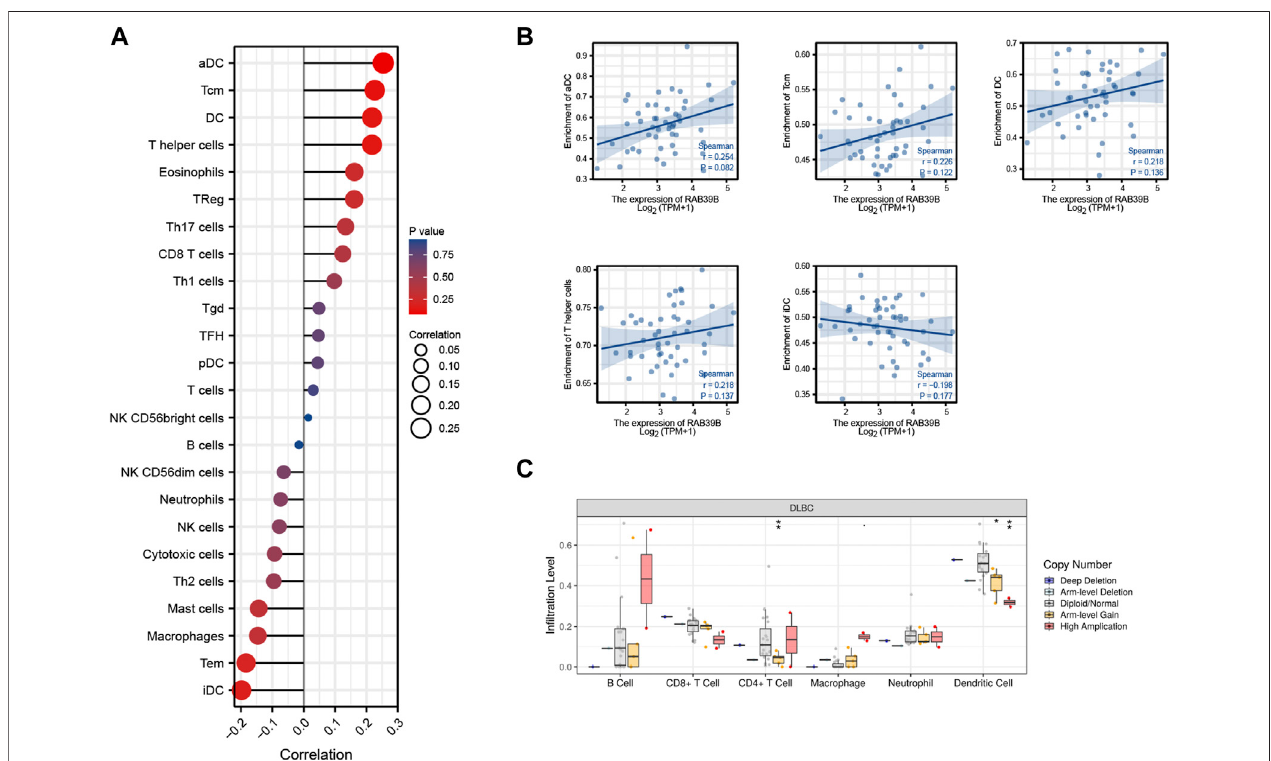
FIGURE 4 | Relationship between RAB39B and immune signatures in DLBCL. (A) Relationship between RAB39B expression and 24 immune cell types. (B) Scatter plots of E2F2 expression with the immune in fi ltration level of aDC, Tcm, DC, T helper cells, and iDC. (C) RAB39B CNV affects the in fi ltrating levels of CD4 + T cell and DC in